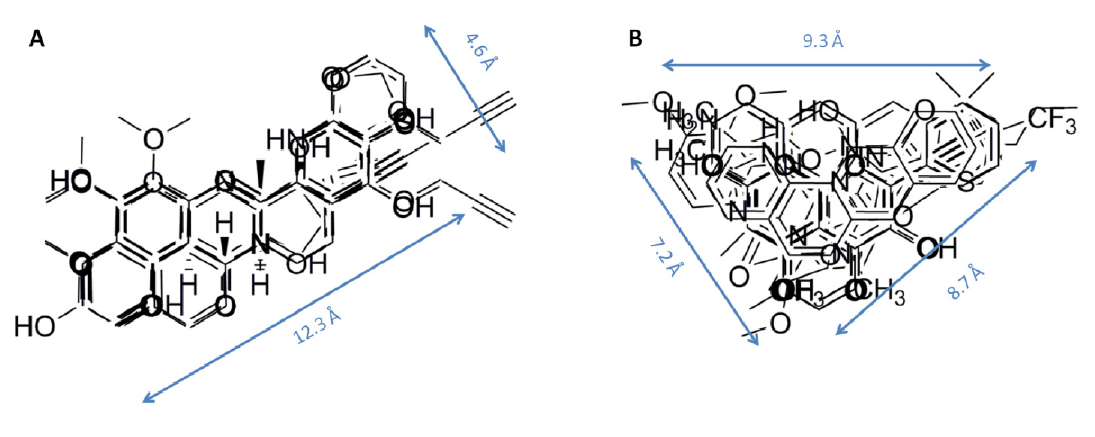
Figure 11. Alignment images of group 1 and group 2 inhibitors. ( A ) Group 1 represents selective P450 1A1 inhibitors; ( B ) Group 2 represents selective P450 1A2